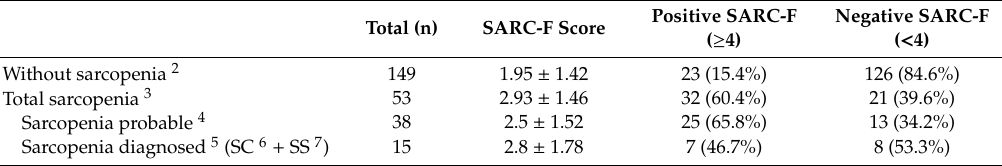
Table 3. Mean score and interpretation of SARC-F test according to sarcopenic status 1. Total (n) SARC-F